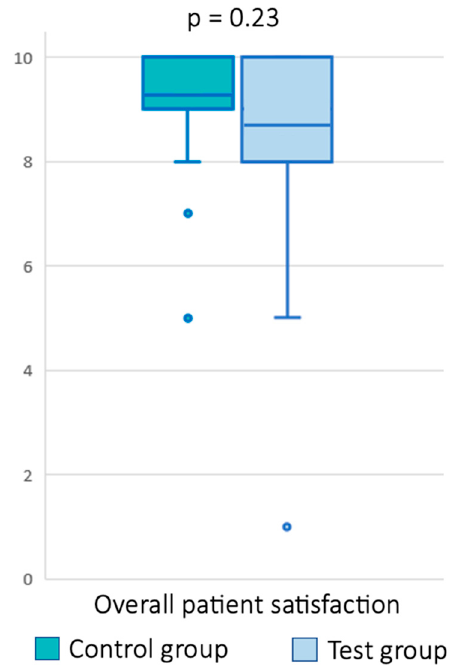
Figure 2. Overall patient satisfaction after a face-to-face consultation (control group) and after a teleconsultation (test group). The dots represent the outlier values.